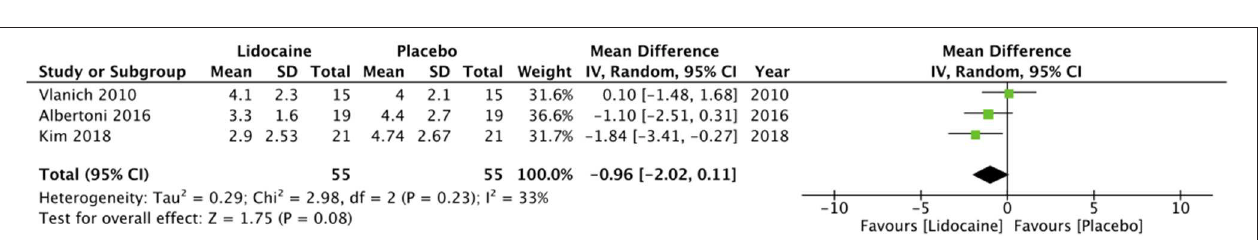
FIGURE 4 | Forrest plot of IV lidocaine vs. placebo for pain persistent pain